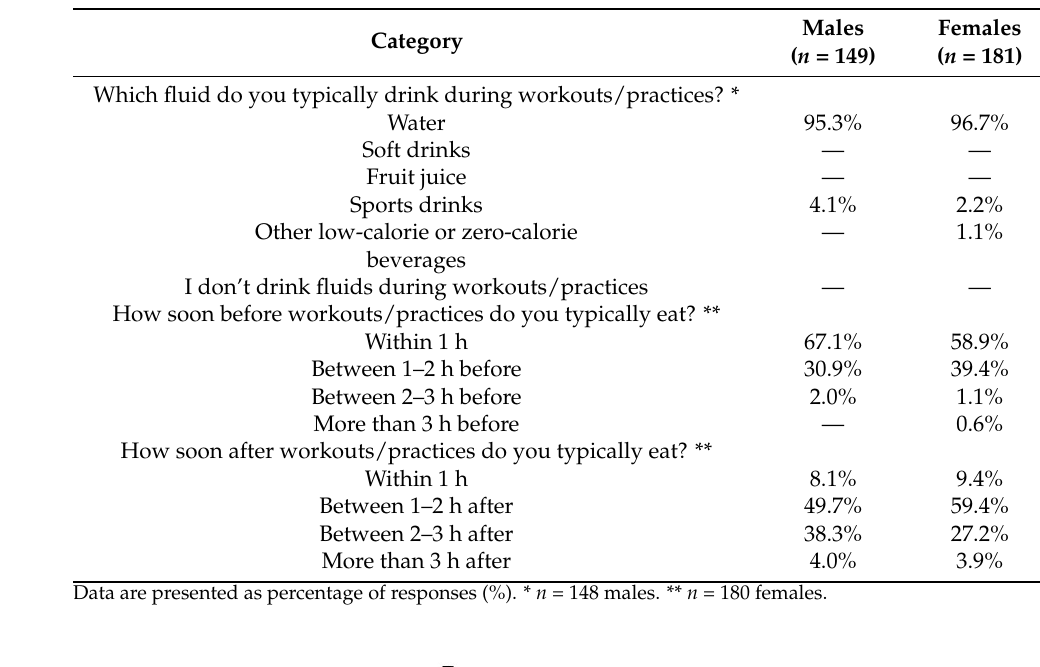
Table 4. Sport-related dietary habits of athletes.